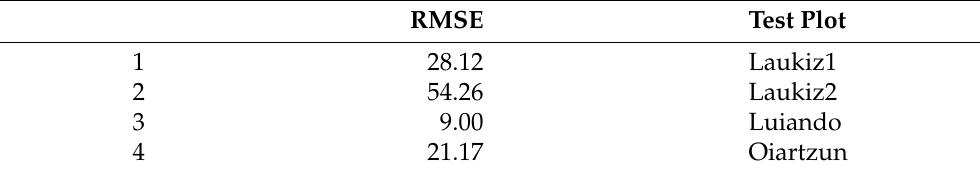
Table 4. Test fold performances in RMSE (p.p.) for learner SVM on the HR dataset without using a filter, showcasing performance variance on the fold level. For each row, the model was trained on observations from all others plots but the given one and tested on the observations of the given plot.